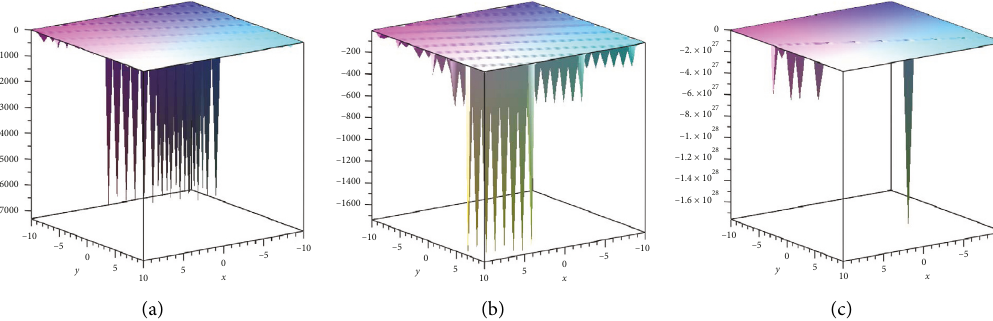
� 1 ,l � 3 ,l � 2 , k � 1 ,k � 2 ,k � − 1 , and ξ � 1 at different times. 0 1 2 1 2 3 0